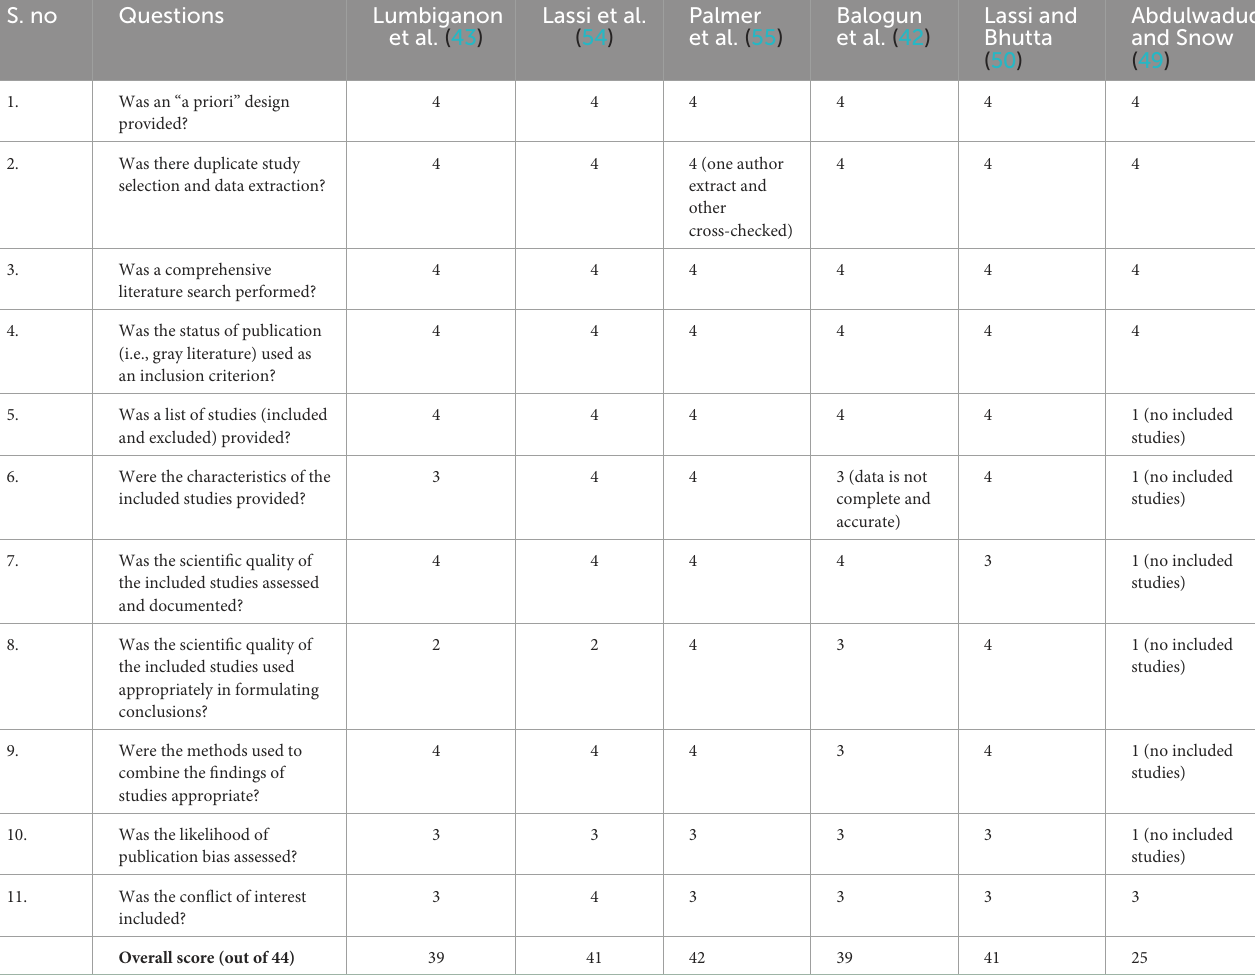
TABLE 5 Methodological quality of included studies. S.